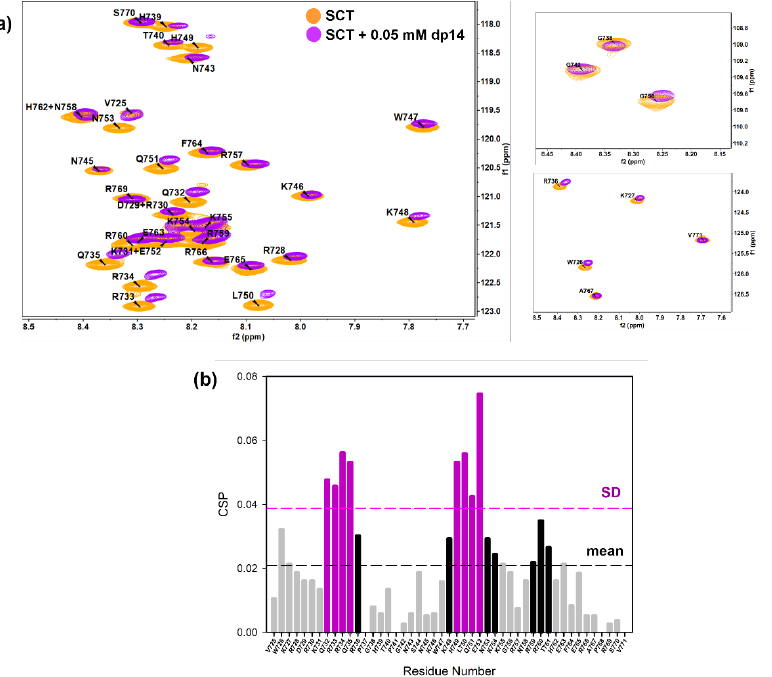
Figure 4. ( a ) Overlay of [ 1 H- 15 N]-HSQC spectra of 0.2 mM Sema3A C-terminal region in the absence (orange) and the presence of 0.05 mM (or 0.35 mM in disaccharide units) dp14 heparin oligosaccharide (purple). ( b ) Weighted chemical shift perturbation (CSP) of C-terminal Sema3A region in the presence of dp14 heparin. The absolute values of the chemical shift differences between the presence and absence of dp14 are plotted in ppm and calculated using the weighting factors, described in [57]. Spectra were acquired in 10 mM acetate, 150 mM NaCl, pH 4.5, 10% D 2 O. Figure 4a illustrates the chemical shift perturbation of the backbone amide groups of SCT WT (0.2 mM) in the presence of 0.05 mM (or 0.35 mM in disaccharide units) dp14 hep- arin oligosaccharide. NMR signals retained low dispersion, showing that the protein re- mains disordered and flexible in the complex. As shown in Figure 4a, binding to dp14 heparin causes a loss of intensities and significant chemical shift changes in specific re- gions. Furthermore, we essentially observed a resonance shift upon addition of dp14 hep- arin, implying a fast exchange on the NMR time scale between the free and the heparin bound states. The chemical shift map (Figure 4b) reveals pronounced chemical shift changes (black line cutoff = CSP mean) for residues in sequences 732 QRRQR 736 and 748 KHLKENKK 755 , while mild changes for residues Trp726 and Arg760. Some of them be- long to the typical GAG-binding motif – X m BBX m - (XBBXBBXBBX, as FS2 peptide 725 VWKRDRKQRRQR 736 ), where B is a basic amino acid and X is a hydrophilic amino acid